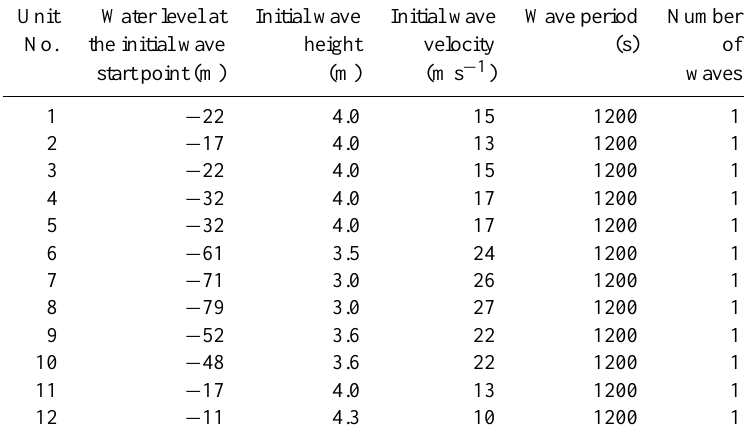
Table 2. The initial wave setting for the calculation